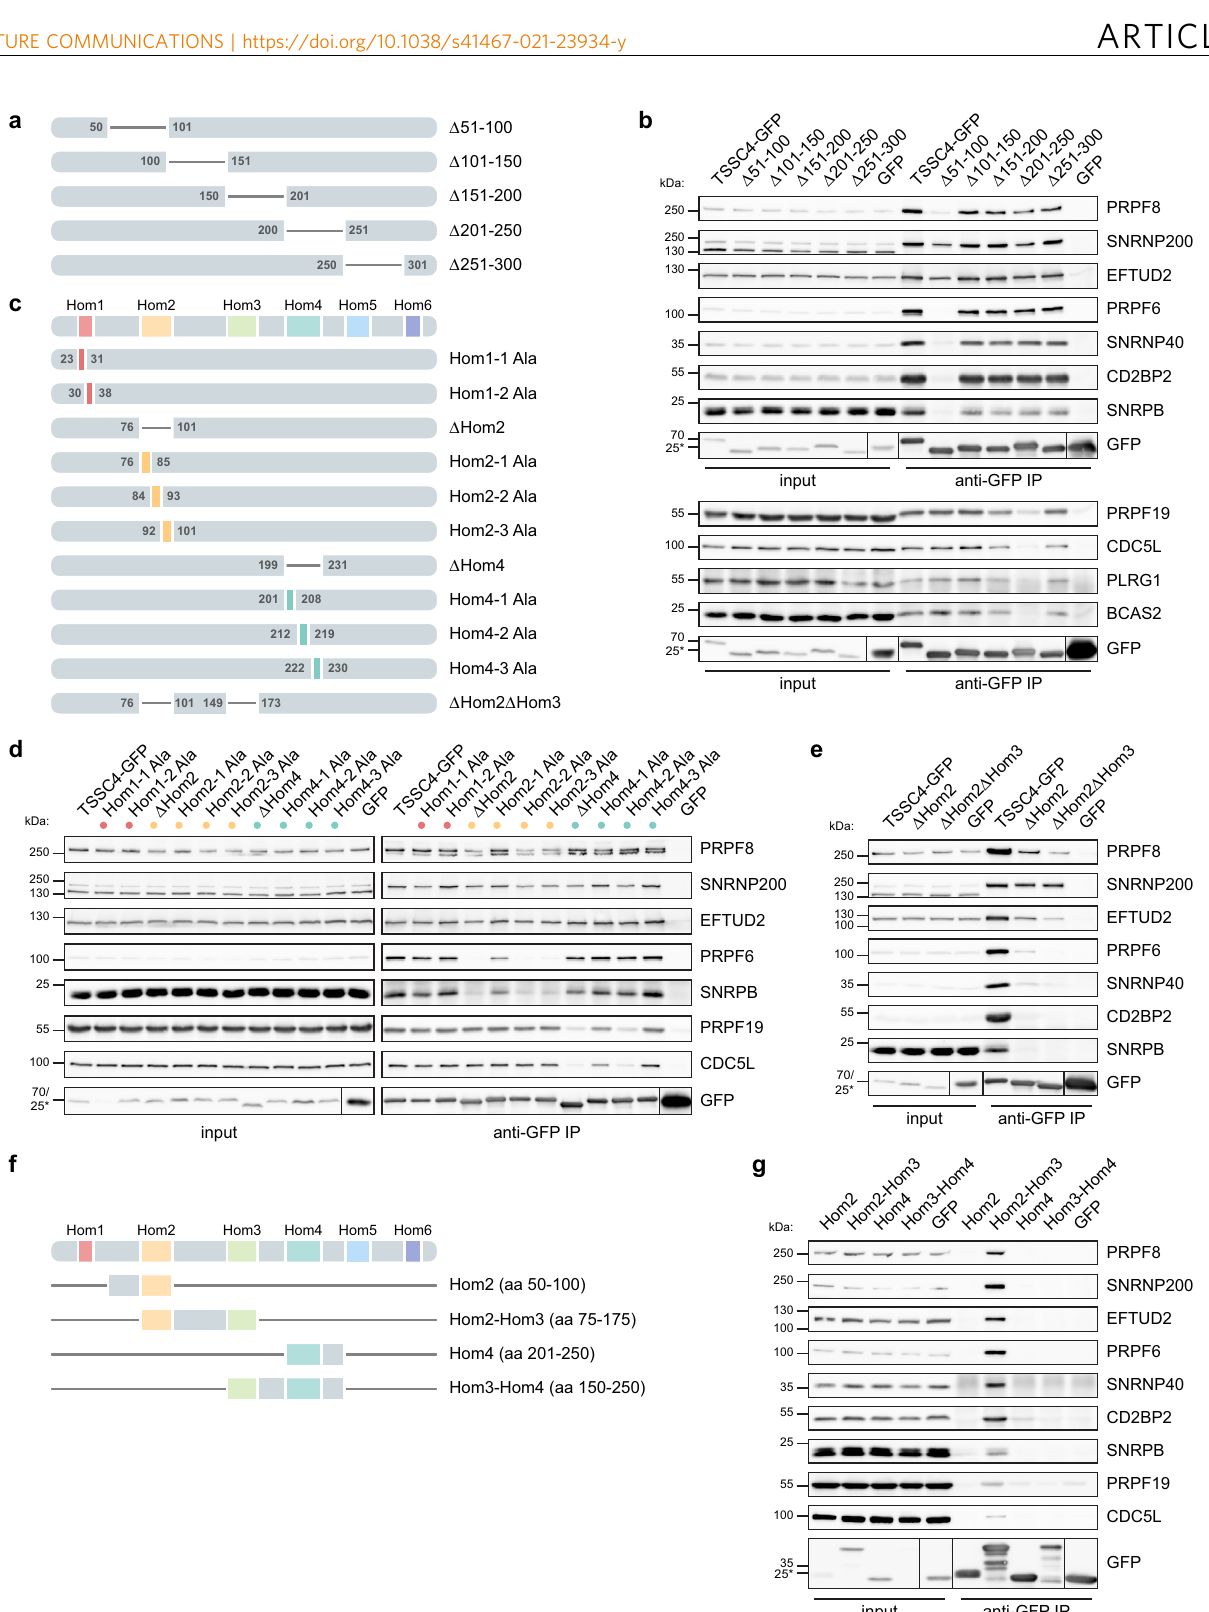
A protein sequence comparison of TSSC4 done using T-Coffee tool 40 across the animal kingdom revealed six conserved domains, which we named Hom1 – Hom6 (Supplementary Fig. 2c and Fig. 3c). These homology regions largely correspond to conserved regions identi fi ed previously by comparing human and mouse TSSC4 sequences 41 . We also performed an in silico NATURE COMMUNICATIONS| (2021) 12:3646